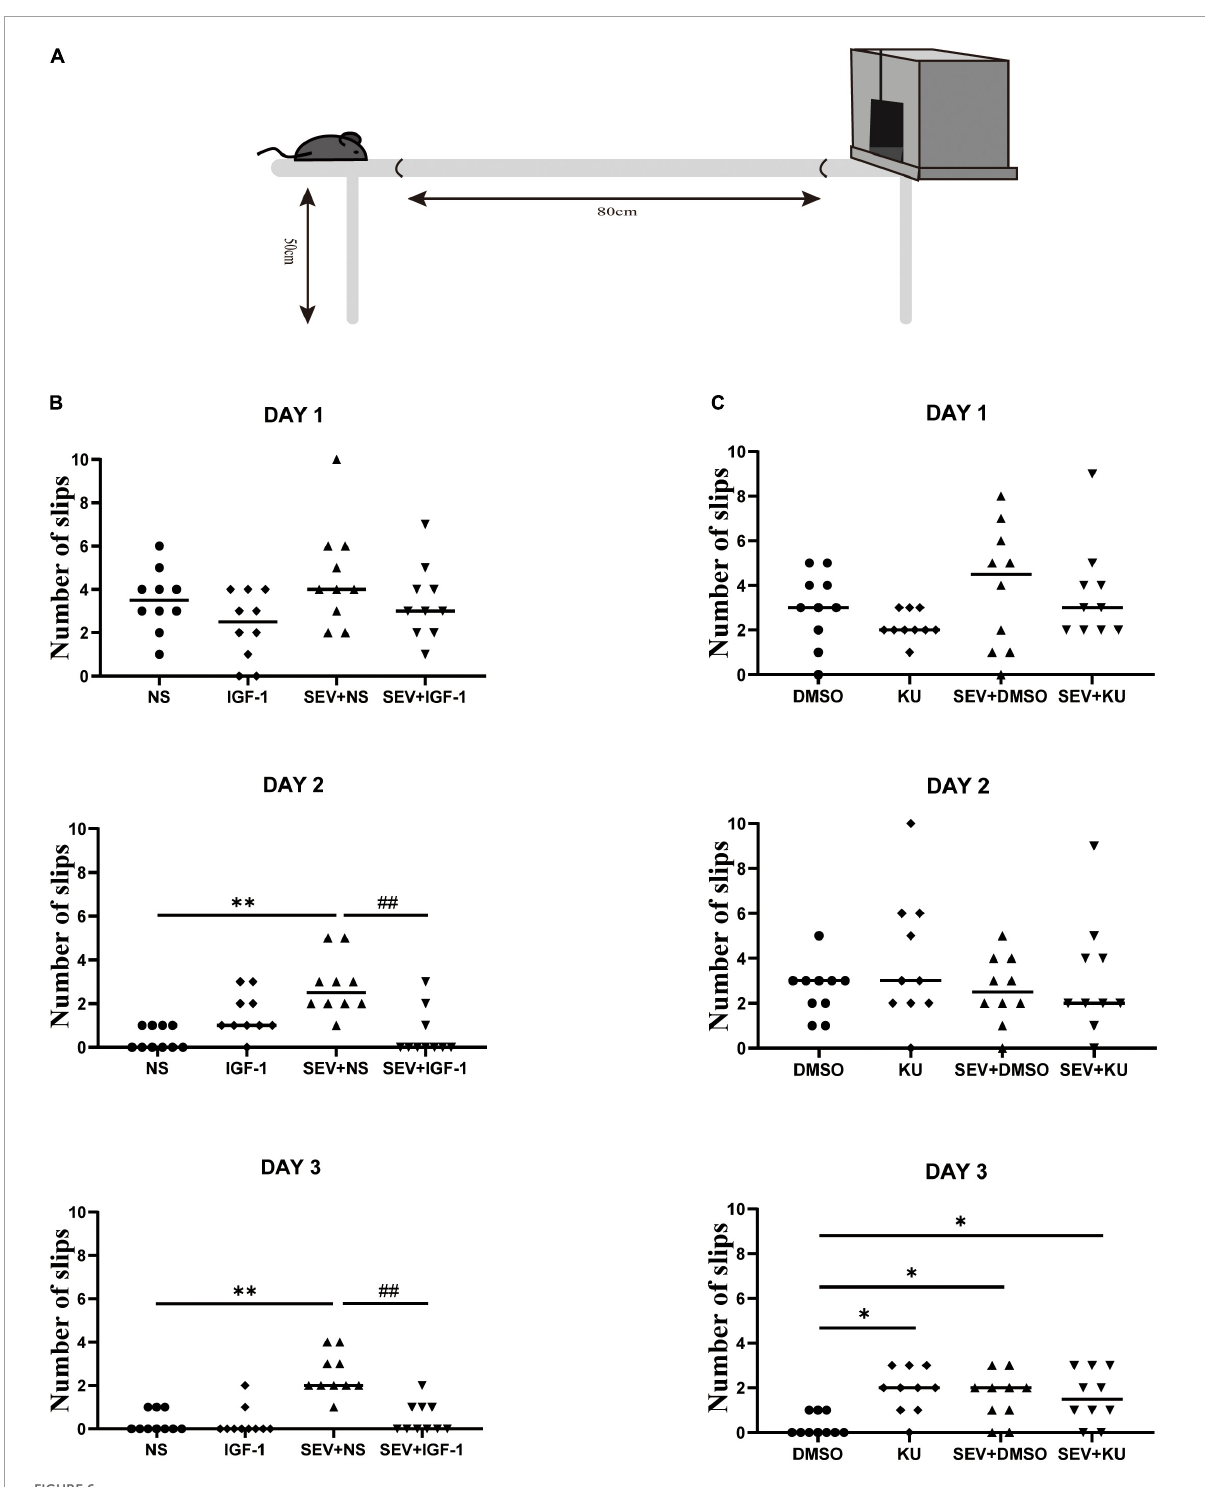
FIGURE6 IGF-1 can rescue sevoflurane-induced deficits in fine motor function, and KU0063794 can induce fine motor impairment which is similar as sevoflurane-induced. (A) Schematic diagram of the beam walking test. (B,C) The numbers of slips of beam walking test at PND 48 over three consecutive days in all groups by one-way ANOVA, n = 10 for each group. * P < 0.05, ** P < 0.01 vs. NS or DMSO; # P < 0.05, ## P < 0.01 vs. SEV +